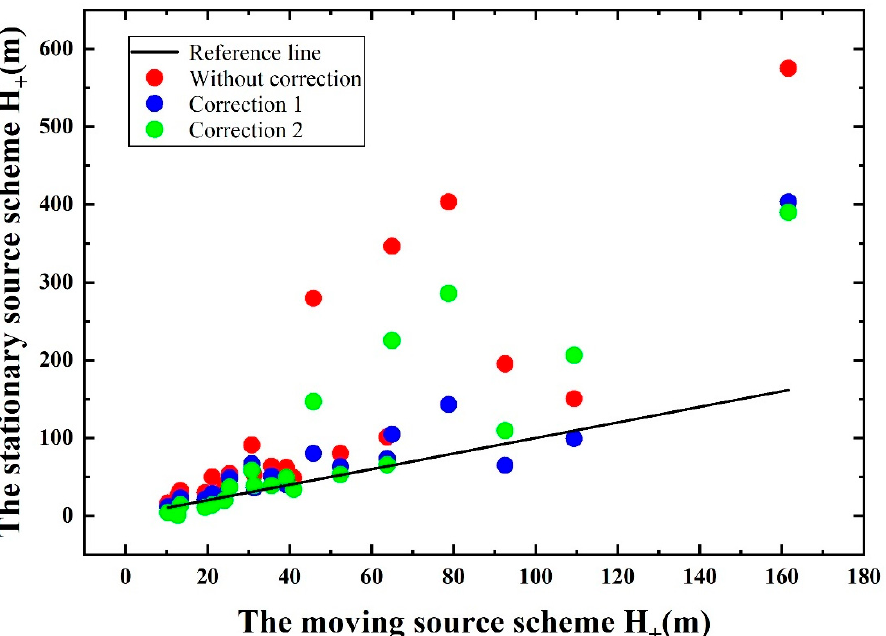
Figure 14. The comparison between the smoke plume rising height (H + ) at 1 km downwind simulated